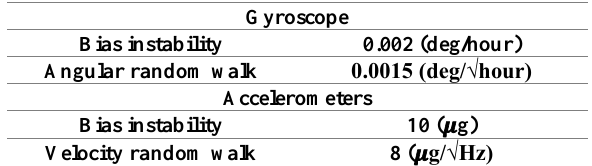
Table 5 .Specification of iMAR-iNAV-RQH-10018